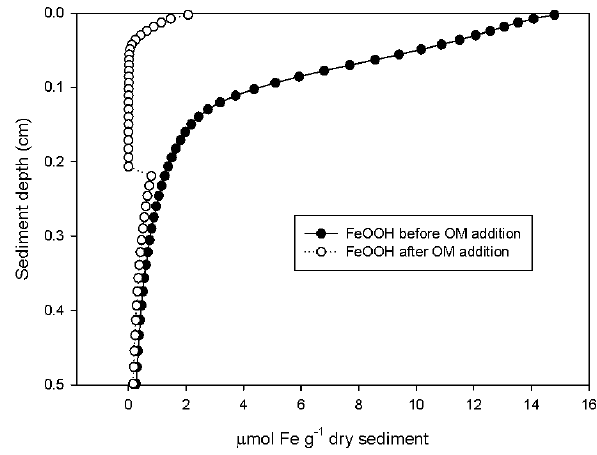
Fig. 5. A simulation showing the FeOOH concentration before and after an organic matter pulse with initial FeOOH concentration of 19µmolg − 1 sediment ( d/w ). Note: The step around 0.2cm is due to the pulse of organic matter added to only the top